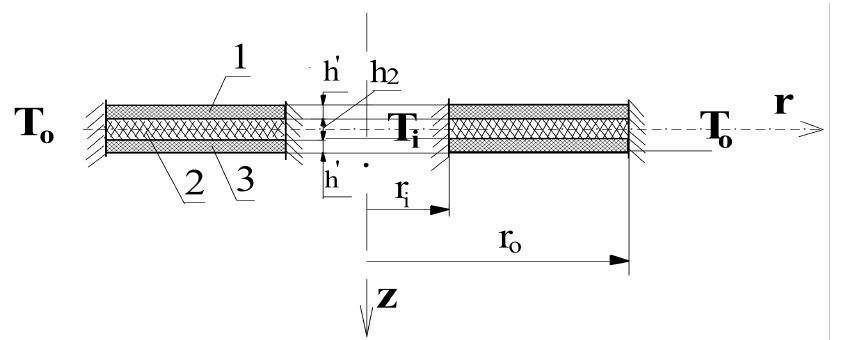
Figure 1. Scheme of the three-layered annular plate composed of facings (layers 1, 3) and core (layer 2) subjected to axisymmetrical temperature field expressed by T i , T o